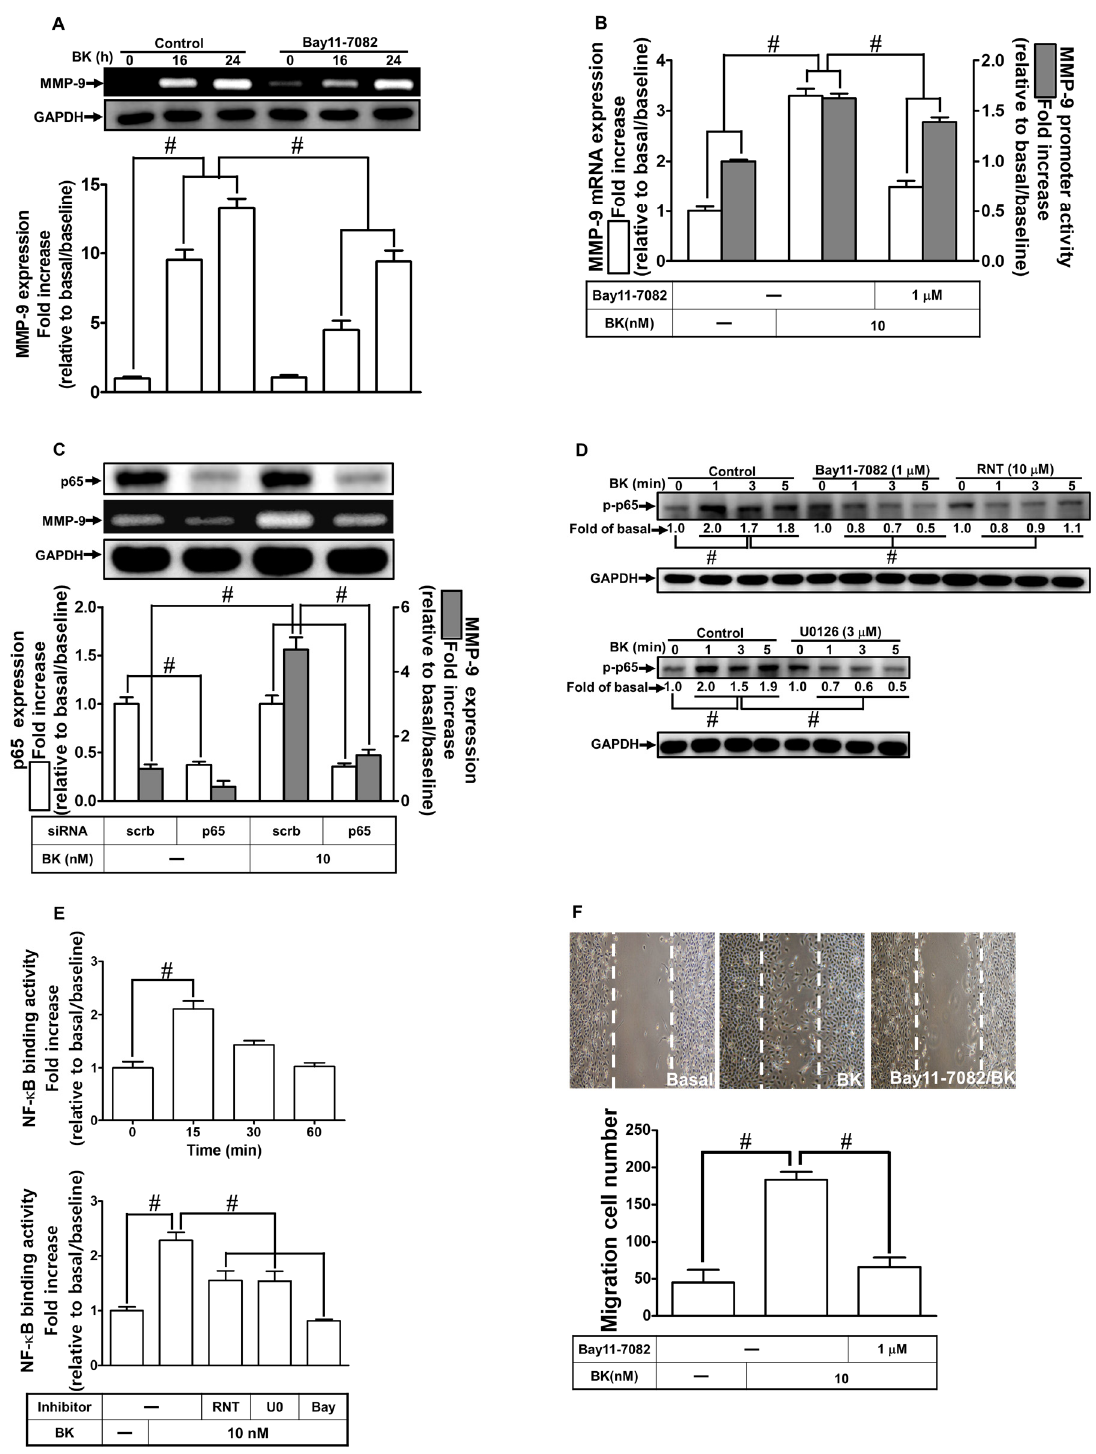
Figure 6. RNT blocks NF- κ B activity and promoter binding ability induced by BK in RBA-1 cells. ( A ) Cells were pretreated with 1 μ M Bay11-7082 for 1 h and then stimulated with BK (10 nM) for 16 and 24 h. The levels of MMP-9 in the media and GAPDH in cell lysates were examined by gelatin zymography and Western blot, respectively. ( B ) Cells were pretreated with 1 μ M Bay11-7082 for 1 h and then incubated with BK (10 nM) of 6 h for analyzing MMP-9 mRNA expression and promoter activity, respectively, by real-time PCR and promoter assay. ( C ) Cells were individually transfected with scram- bled (Scrb) or p65 siRNA and then incubated with BK (10 nM) for 24 h. The media and cell lysates were collected to determine the levels of MMP-9 by gelatin zymography and the levels of GAPDH and p65 by Western blot, respectively. ( D ) Cells were individually pretreated without or with inhibitors of Bay11-7082(1 μ M), U0126 (3 μΜ ), or RNT (10 μ M) for